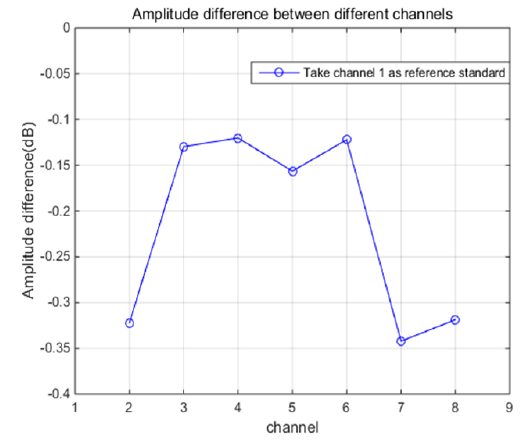
Figure 13. Amplitude errors between channels.